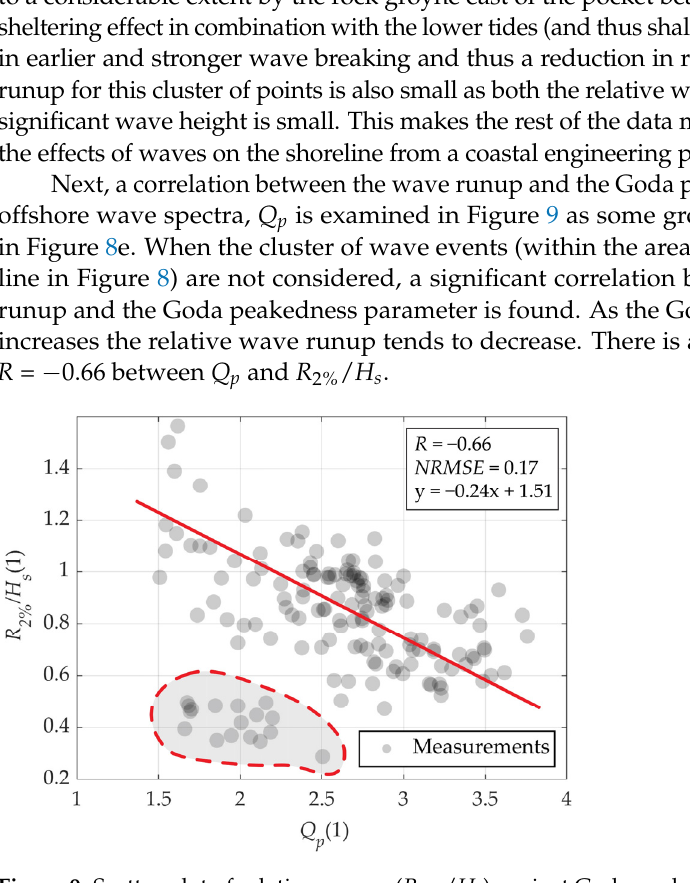
Figure 9. Scatter plot of relative run up ( R 2% / H s ) against Goda peakedness parameter ( Q p ) on the centerline profile (profile 2 in Figure 1d) on the fetch-limited gravel beach; the area enclosed by a red dashed line marks a cluster of data points that exhibit specific swash behavior, which occurs at highly oblique wave directions, low tides, low significant wave heights, and low wave spread. Detailed information can be found in the text in Section 3.3.